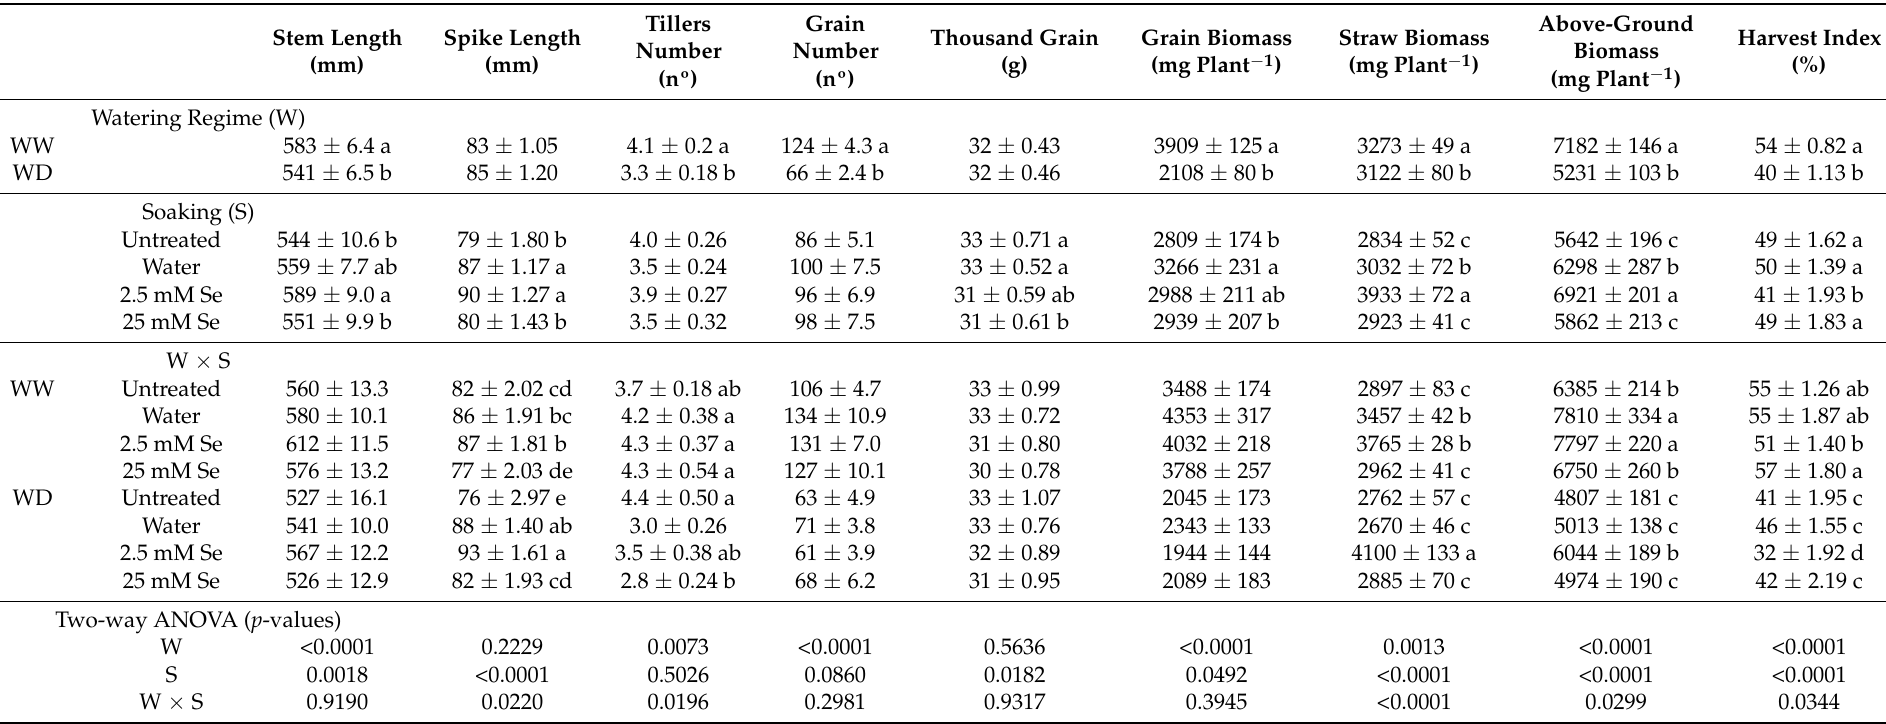
Table 1. Stem length (mm), spike length (mm), tillers number, grain number, thousand-grain weight (g), grain harvest index (%), grain biomass per plant (mg plant − 1 ), straw biomass (mg plant − 1 ), above-ground biomass (mg plant − 1 ) parameters at the maturity stage of wheat plants under two water treatments and four Se treatments. Values are means ± SE ( n = 20). Different letters indicate statistically significant differences ( p <